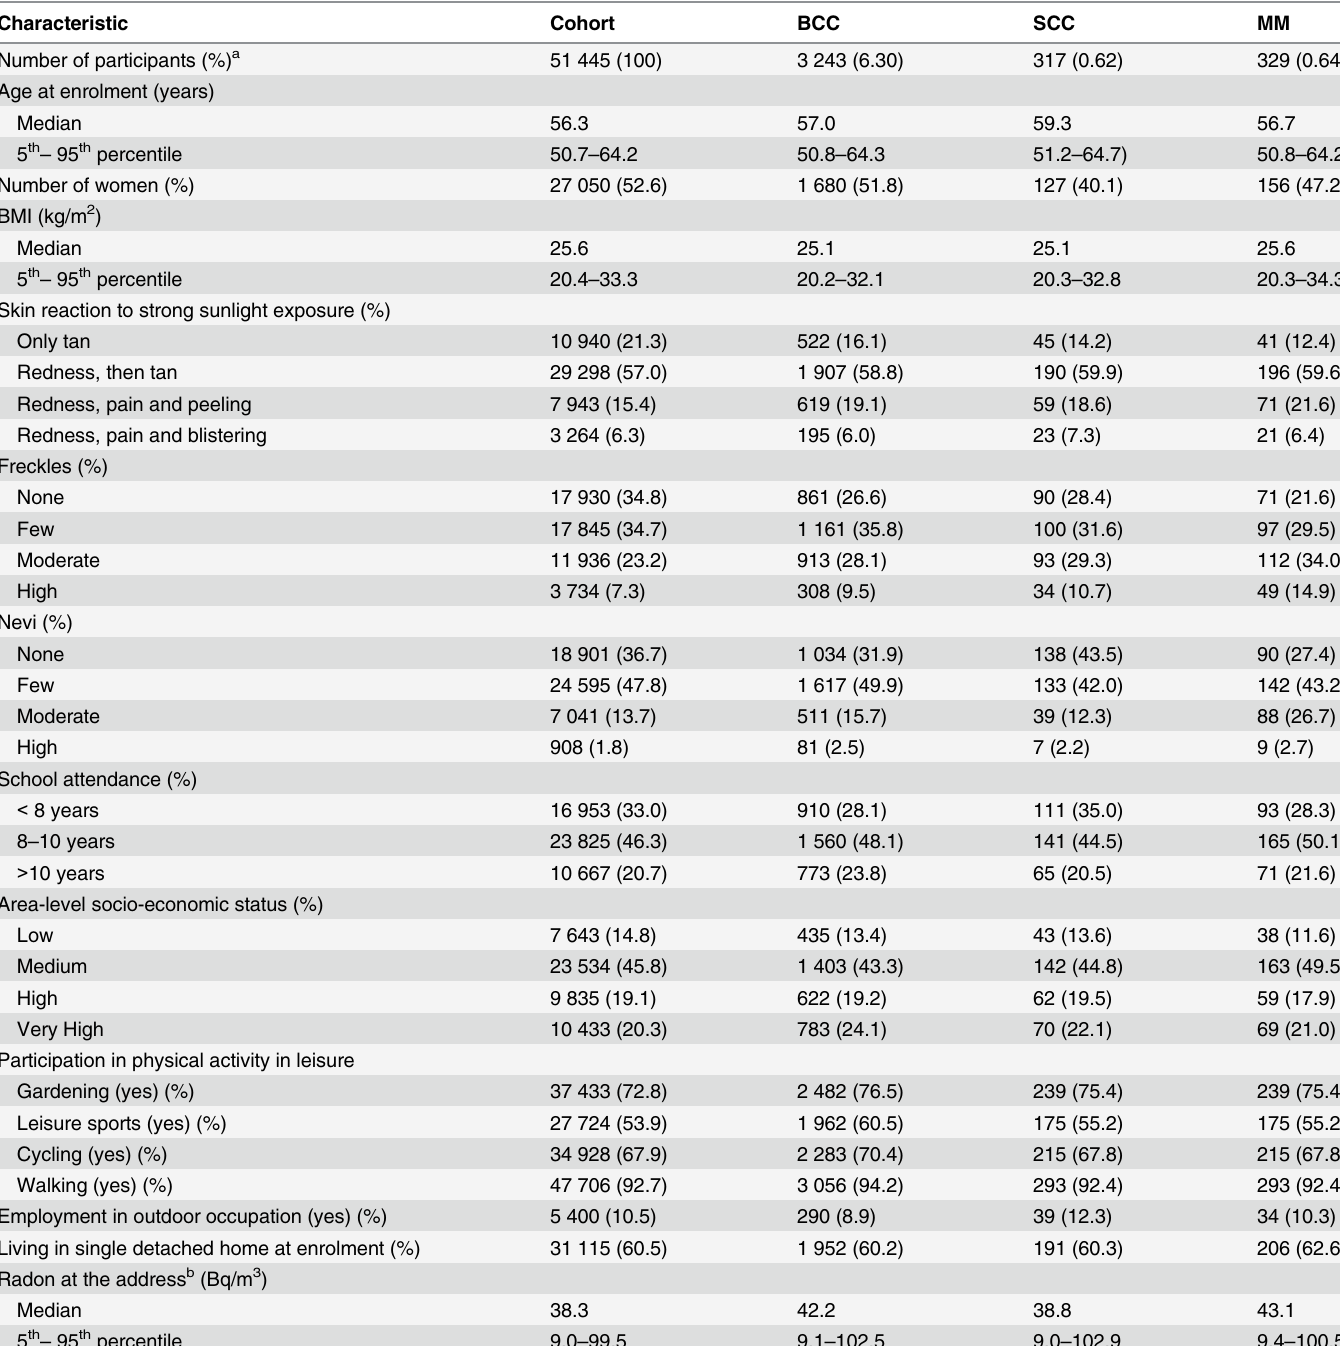
a Row percentages. All other percentages are column percentages.